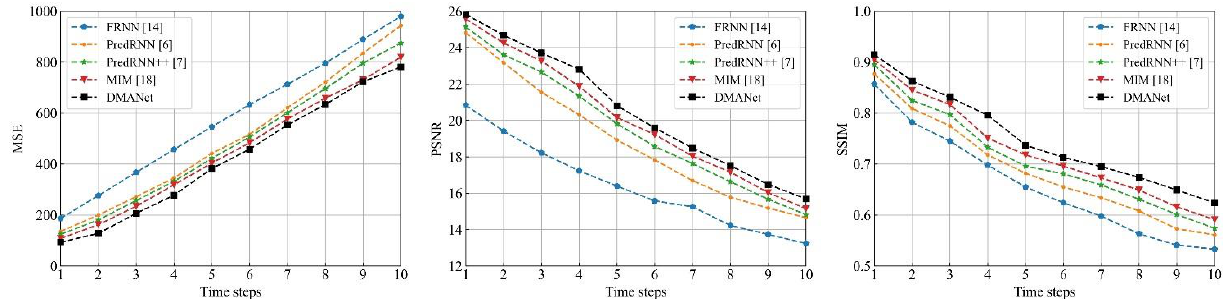
Figure 15. Frame-by-frame quantitative results for the 10 frames at the Caltech [36].